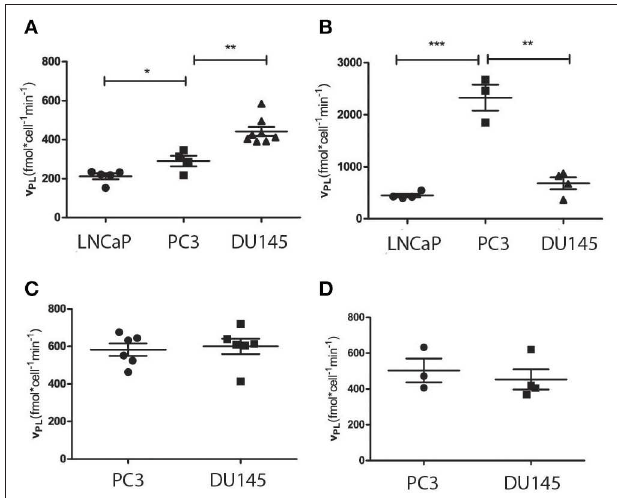
FIGURE 5 | Rate of pyruvate to lactate conversion obtained from the experiments carried out using HP [1-13C]pyruvate on cells, in different conditions: (A) intact cells (DU145, PC3 and LNCaP cells) cultured in their proper culture medium, (B) intact cells suspended in the medium with added lactate; (C) lysed cells and (D) cells cultured in the same medium (DMEM). * P ≤ 0.05, ** P ≤ 0.01, *** P ≤ 0.001; unpaired